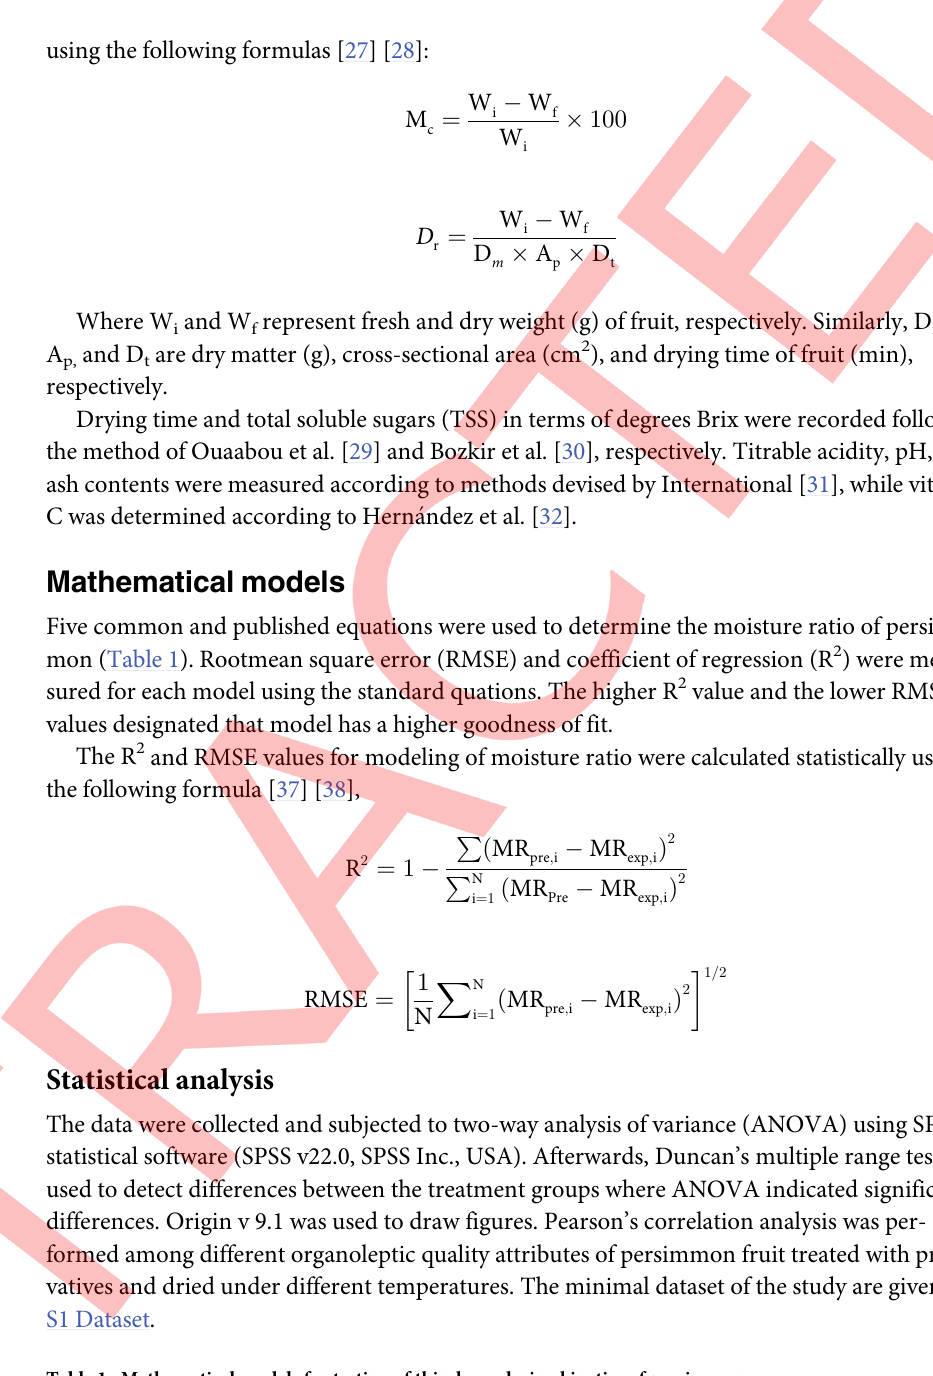
Table 1. Mathematical models for testing of thin-layer drying kinetics of